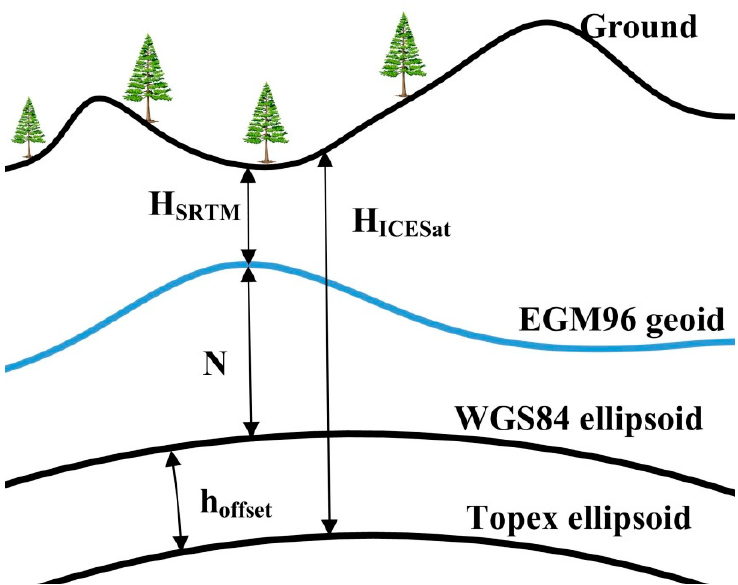
Figure 2. Relationship between the heights of ICESat/GLAS data and SRTM DEM.